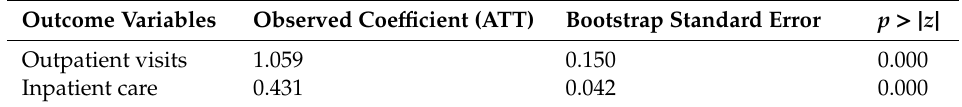
Table 3. Propensity score matching results on average treatment e ff ect (ATT)in TB health care utilization. Outcome Variables